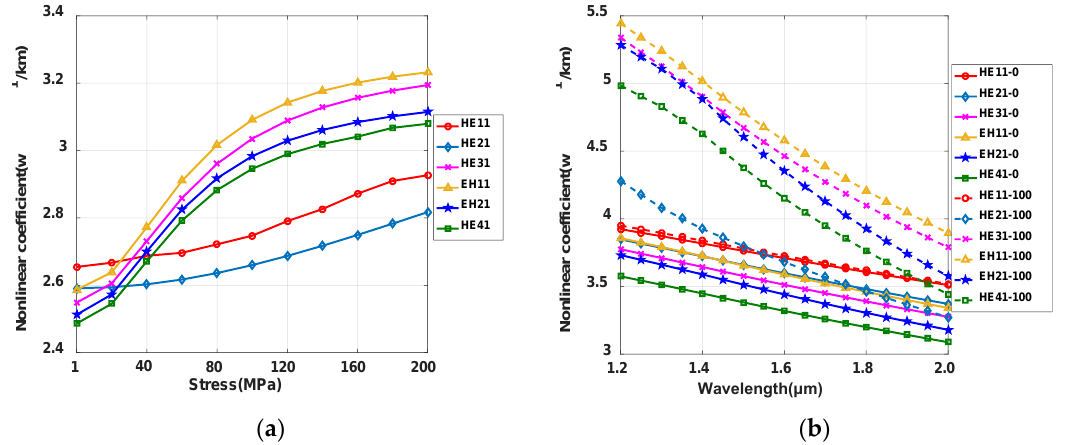
Figure 16. ( a ) Nonlinear parameter as a function of stress for different modes, and ( b ) nonlinear parameter as a function of wavelength for different modes under 100 MPa stress in the y direction.